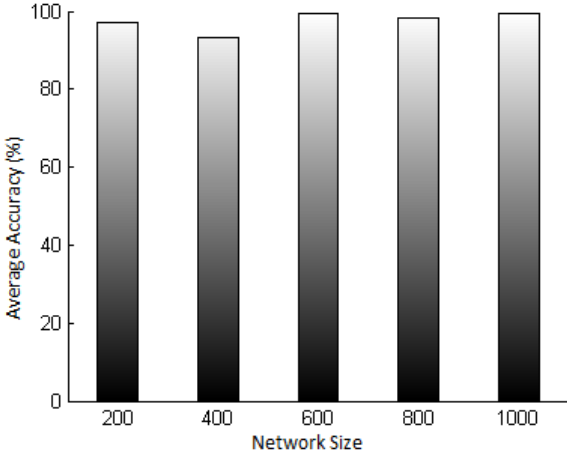
Figure 12. Accuracy of the estimated security level, for differently sized